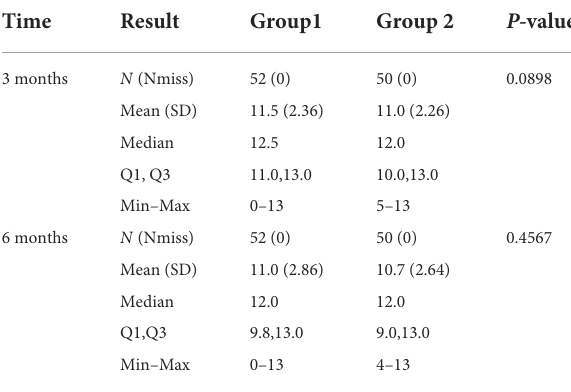
TABLE 9 Graft Strength and Integrity Score based on MRI.